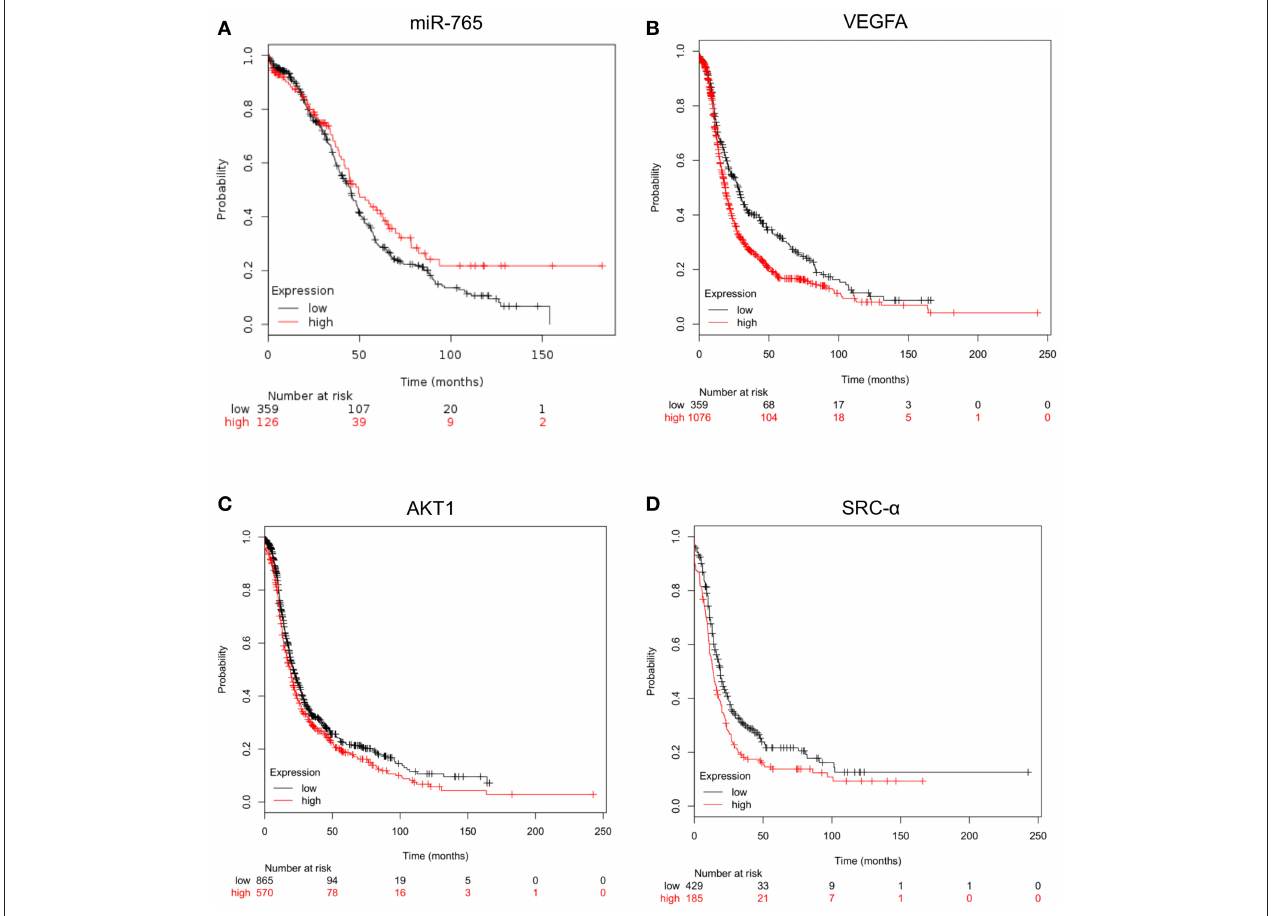
FIGURE 6 | Kaplan-Meier curves for overall survival according the expression of miR-765, VEGFA, AKT1 and SRC- α . Overall survival analysis using Kaplan Meier plotter for (A) miR-765, (B) VEGFA, (C) AKT1, and (D) SRC- α genes. Start KM plotter for ovarian cancer tool used genome-wide for mRNA expression data and overall survival clinical information of cancer patients, which were downloaded from Gene Expression Omnibus GEO (Affymetrix HG-U133A, HG-U133A 2.0, and HG-U133 plus 2.0 microarrays) and The Cancer Genome Atlas TCGA, whereas for miRNAs expression we used Start miRpower for pan-cancer as implemented in the KM plotter. Samples were split into two groups according to various quantile expression of miR-765 ( n = 485) and VEGFA, AKT1 and SRC- α genes in ovarian cancer patients ( n = 1435). Kaplan-Meier survival plots compared the two patient cohorts, and the hazard ratio with 95% confidence intervals and logrank P -value were